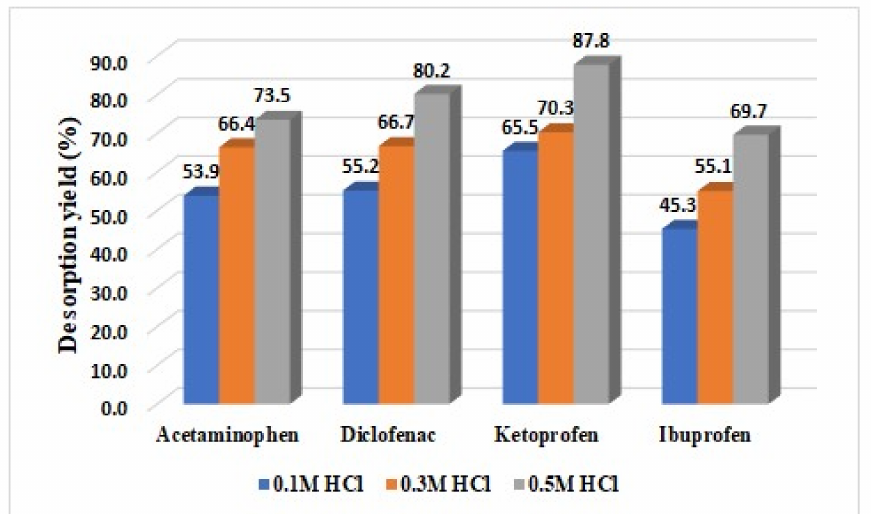
Figure 5. Desorption yields of